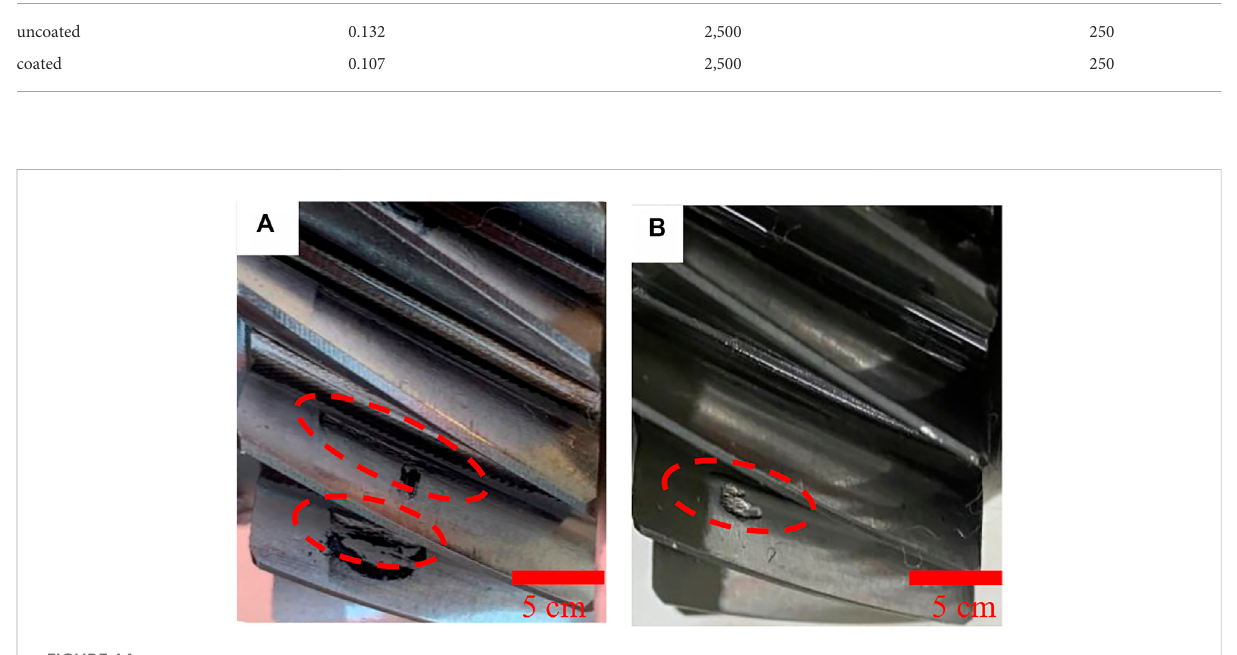
FIGURE 14 Gear after test. (A) Uncoated sample and (B) Coated sample.